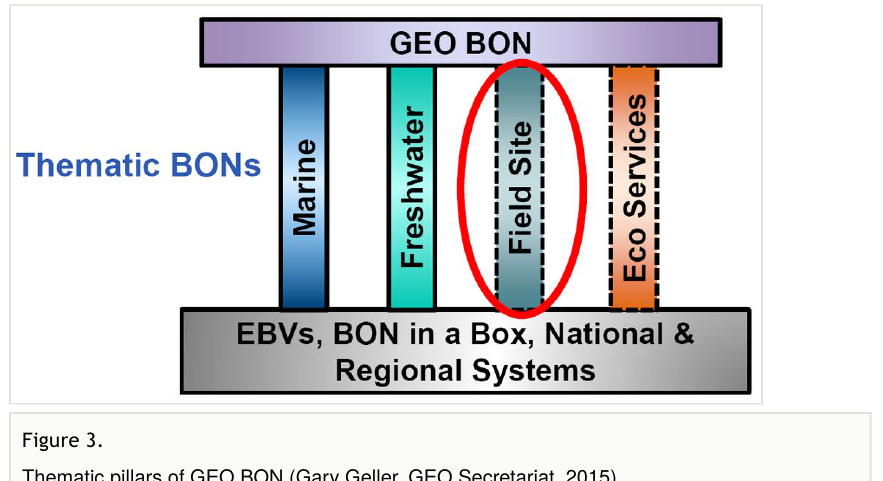
Gary Geller (GEO Secretariat) introduced to the plenary the global acting GEO BON. Its mission is to improve the acquisition, delivery, and application of information on biodiversity change for decision makers. He sees still many gaps along the line of biodiversity observation, data storing and processing up to providing the data for decision makers. Therefore, GEO BON developed a tool box (“BON in a Box”), and supports national and regional BONs – where e.g. America, Africa and Australia are missing. It also works via thematic pillars (Fig. 3) for example on the marine and freshwater realm as well as on fi eld sites, eco-services and on a Global System of Ecosystem Observatories.